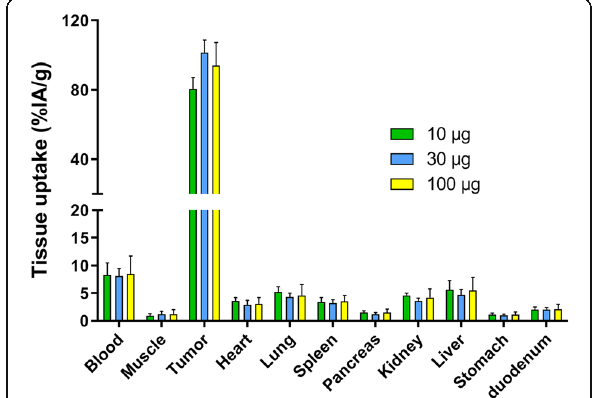
Fig. 2 Biodistribution of 10 μ g ( n = 5, green), 30 μ g ( n = 5, blue), and 100 μ g ( n = 4, yellow) dual-labeled trastuzumab in mice with orthotopic BT474 tumors 48 h after administration. Tumor uptake after injection of 30 μ g [ 111 In]In-DTPA-trastuzumab-IRDye800CW was the highest %IA/g, while there was no significant difference to the 10 and 100 μ g dose levels. Tissue uptake is expressed as %IA/g. Values represent mean ±